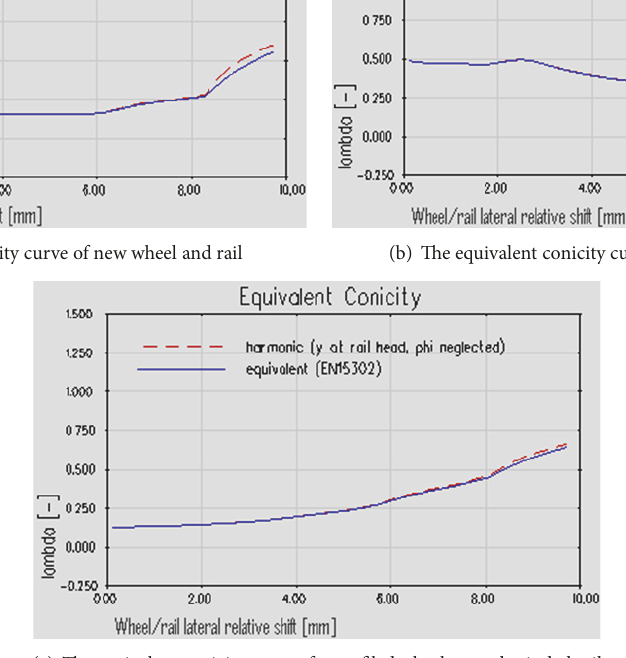
Figure 2: The equivalent conicity curve of different wheel/rail